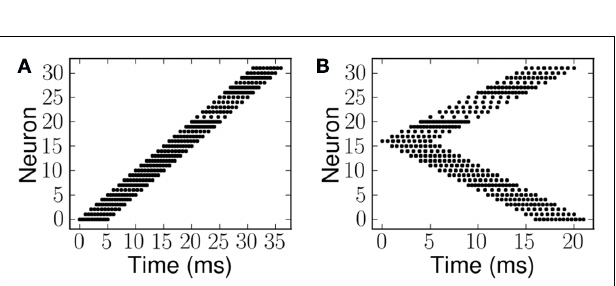
FIGURE 5 | Spike patterns representing the two stimulus classes, linear and forked. Each dot represents a spike and the rate of sweep, the velocity, is given as the number of channels activated per millisecond. (A) Linear frequency sweep at 1.0ms − 1 . (B) Forked frequency sweep where the upper component is 1.0ms − 1